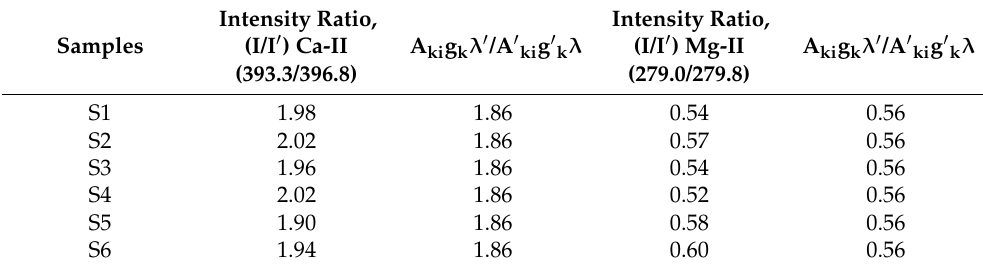
Table 2. Experimental and theoretical intensity of the spectral lines 393.3 nm/396.8 nm for Ca-II and (279.0 nm/279.8 nm) for